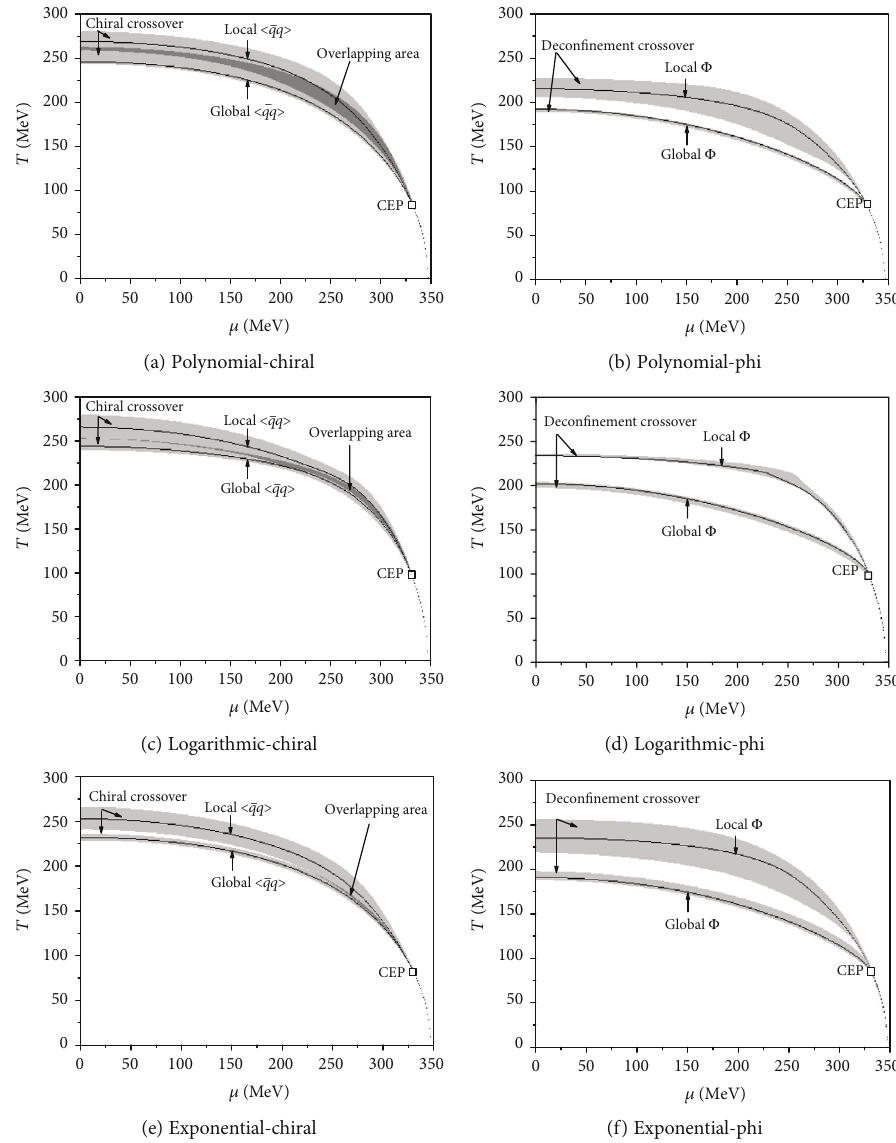
Figure 10: Phase diagram superposition for local and global